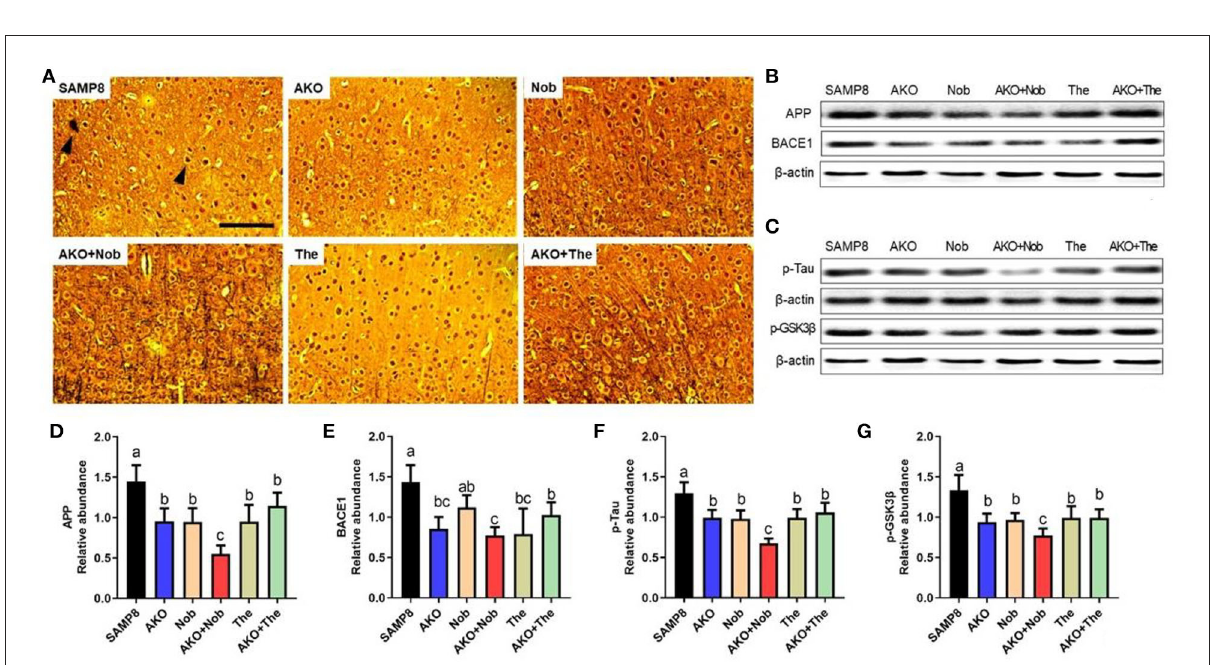
FIGURE2 Effects of neurofibrillary tangles and β -amyloid (A β ) aggregation. (A) The representative image in the brain stained by Bielschowsky silver staining, scale bar = 100 µ m. Brain parenchyma contains lesions such as neurofibrillary tangles and A β aggregation (arrowheads). (B) The representative bands of amyloid precursor protein (APP) and β -site APP cleaving enzyme 1 (BACE1). (C) The representative bands of phosphorylated tau (p-Tau) and phosphorylated-glycogen synthase kinase-3 β (p-GSK3 β ). (D–G) The relative expressions of APP (D) , BACE1 (E) , p-Tau (F) , and p-GSK3 β (G) . All data were presented as mean ± SEM. Different letters indicate a significant difference at p < 0.05 by